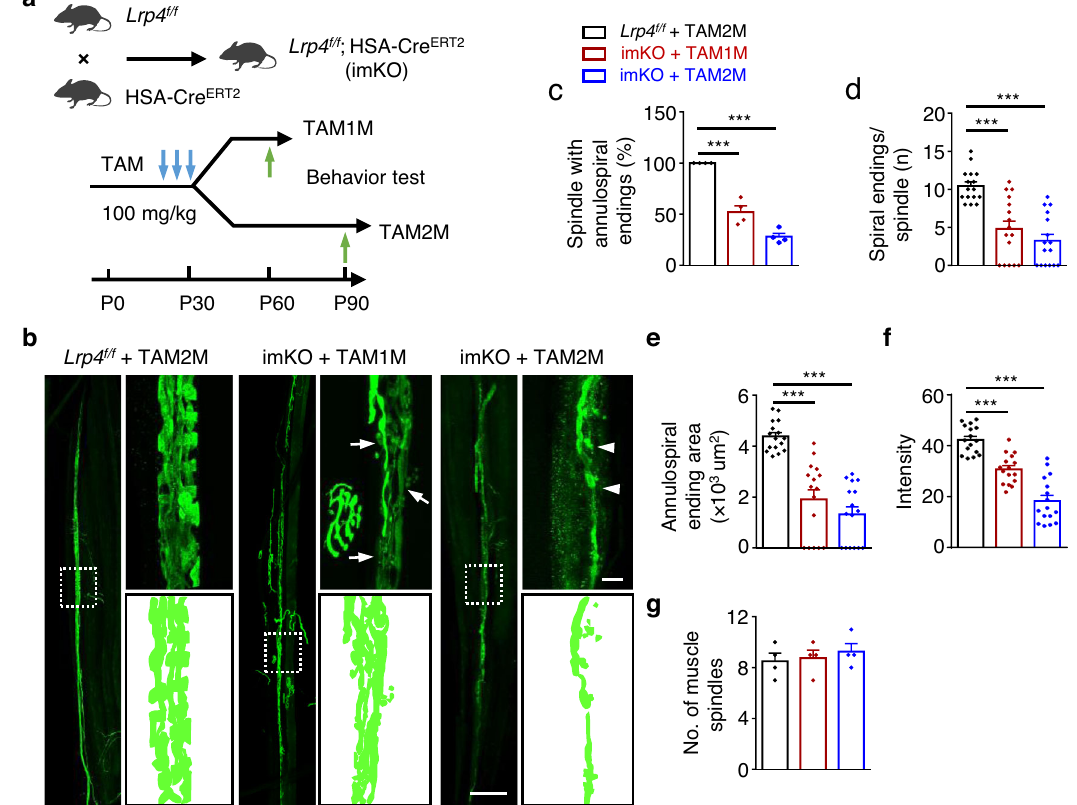
Fig. 4 | Requirement of LRP4 for maintaining muscle spindles. a Illustration of breading Lrp4 f/f ;HSA-Cre ERT2 (imKOforshort)miceandtheschematicoftamoxifen administration, behavior tests and tissue collection. b Disrupted annulospiral endingsintamoxifentreated imKOmice(P60,P90).Representativeimagesof EDL muscles in indicated groups, whole mount stained with NF/Syn (green) to label axon and axon terminals. Muscle spindle was determined by morphology. Square, images enlarged in right panel. Arrows, axon fragmentations; arrowheads, degen- erated axon terminals. Scale bars, 100 µ m and 10 µ m. c – g Quanti fi cation of data in ( b ). c Reduced percentage of muscle spindles with annulospiral endings in tamoxifentreatedimKOmice; t (6) =7.893,*** p =0.0002; t (6) =21.614,*** p <0.0001.